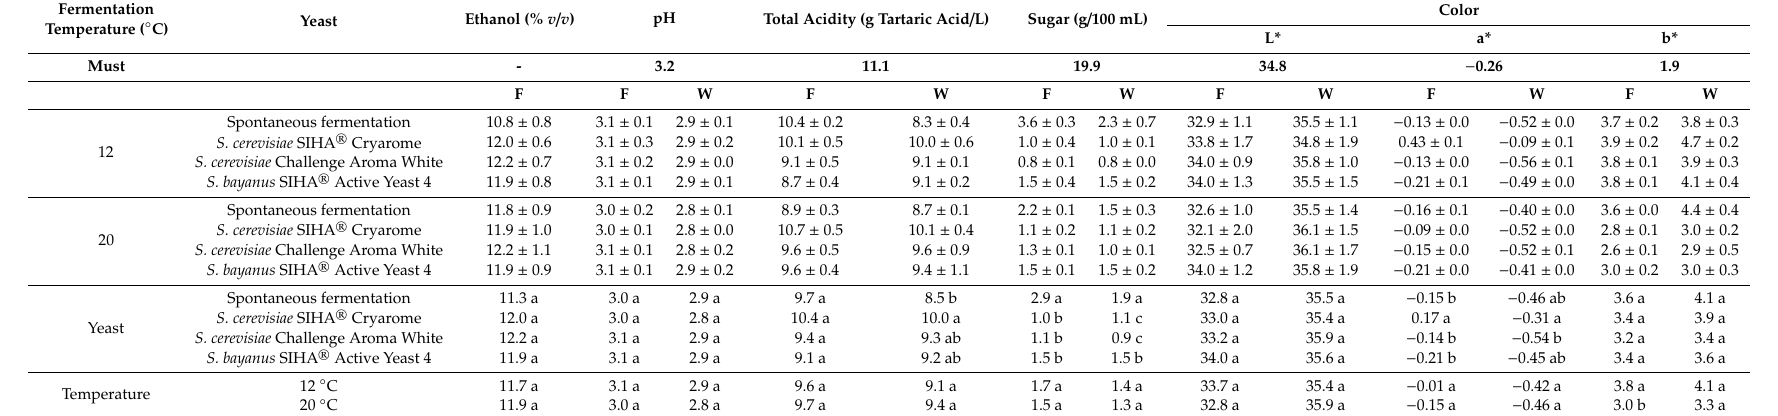
Table 1. Basic parameters of Aurore wine: ethanol content, pH, total acidity, sugar content, and color by CIE L*a*b. Fermentation Temperature ( ◦